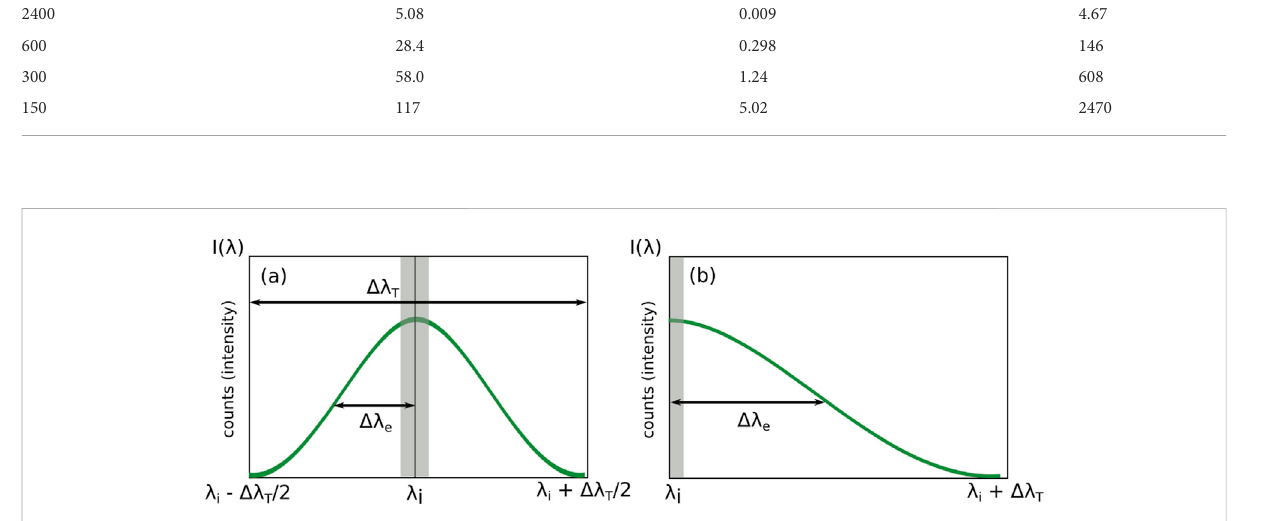
FIGURE 5 Illustration of Thomson spectra (green lines) acquired with (A) the laser wavelength λ i centered in the spectral range or (B) shifted, to access a larger spectra range. The gray bar depicts the regions where spectral information is blocked due to the presence of the volume Bragg grating notch fi lter. The vertical axis represents the number of photon counts recorded by the camera, an amplitude dependent on the wavelength, written as I ( λ ). The full spectral range accessible is Δ λ T and the Gaussian standard deviation is shown as Δ λ e .